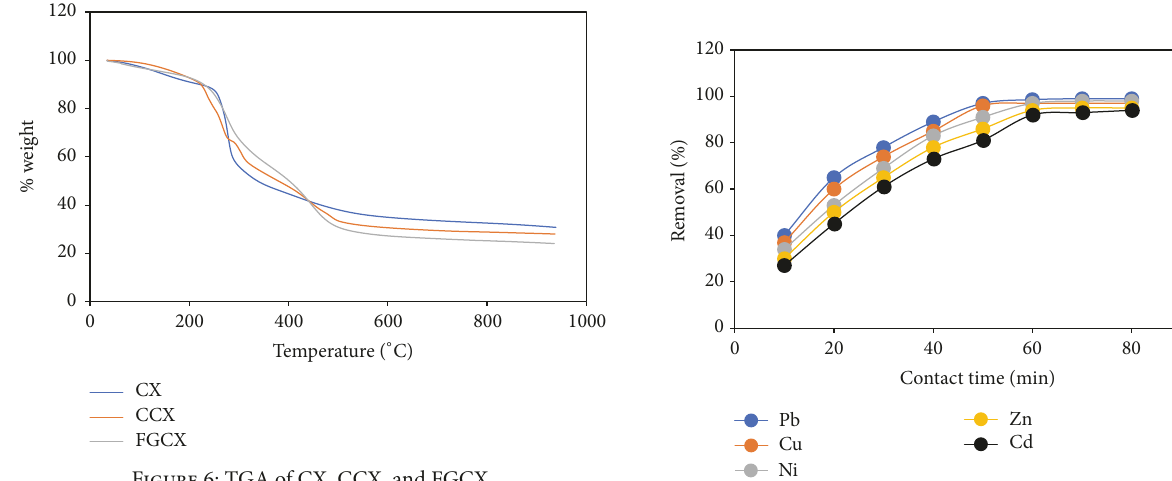
Figure 8: Effect of contact time on percentage removal of heavy metal ions by FGCX (conditions: 7 g/l FGCX; pH: Pb = 5, Cu = 5, Ni = 7, Zn = 6, and Cd = 6; Temperature: 25 ∘ C; initial concentration: 0.8 mmol/L; agitation speed: 120